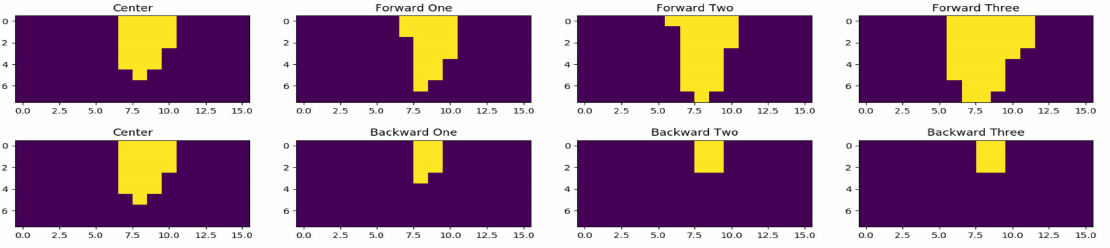
Figure 12. Connected components for forward and backward movements with respect to the center.